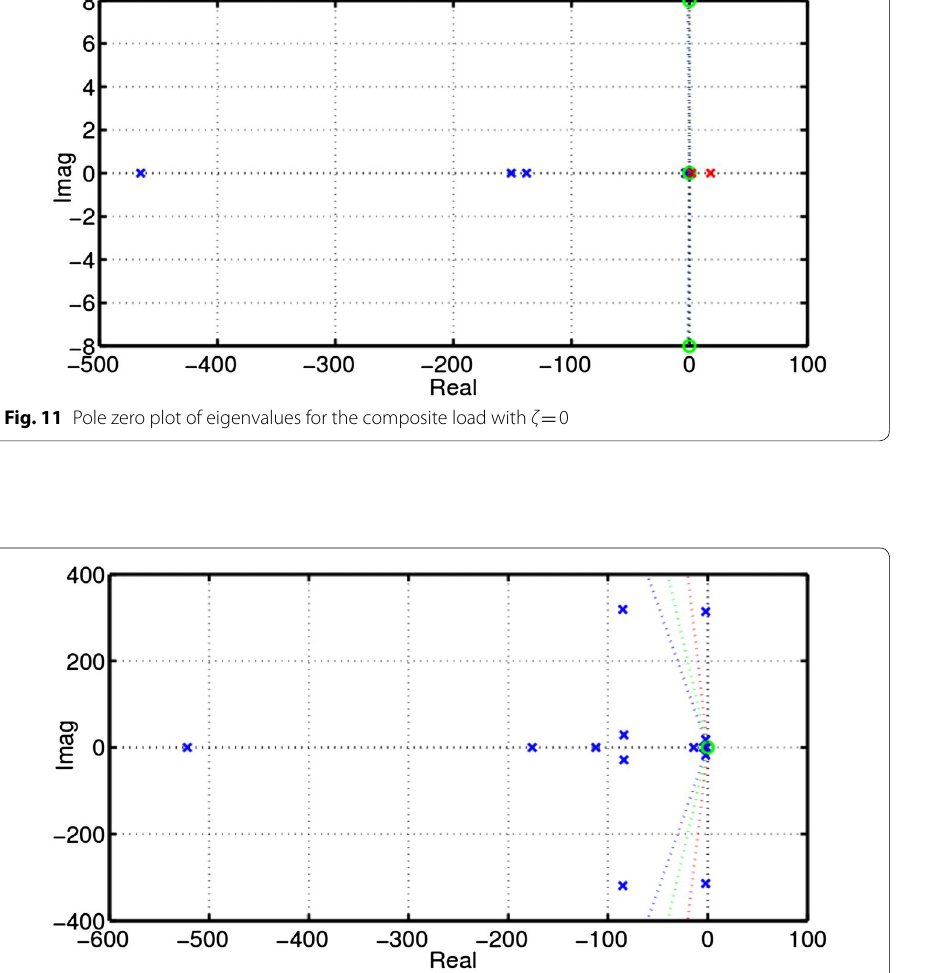
Fig. 12 Pole zero plot of eigenvalues for the composite load with ζ